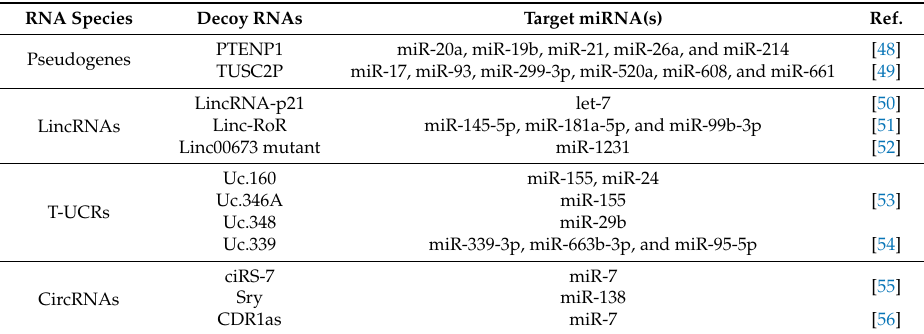
Table 1. Selected examples of non-mRNA–miRNA